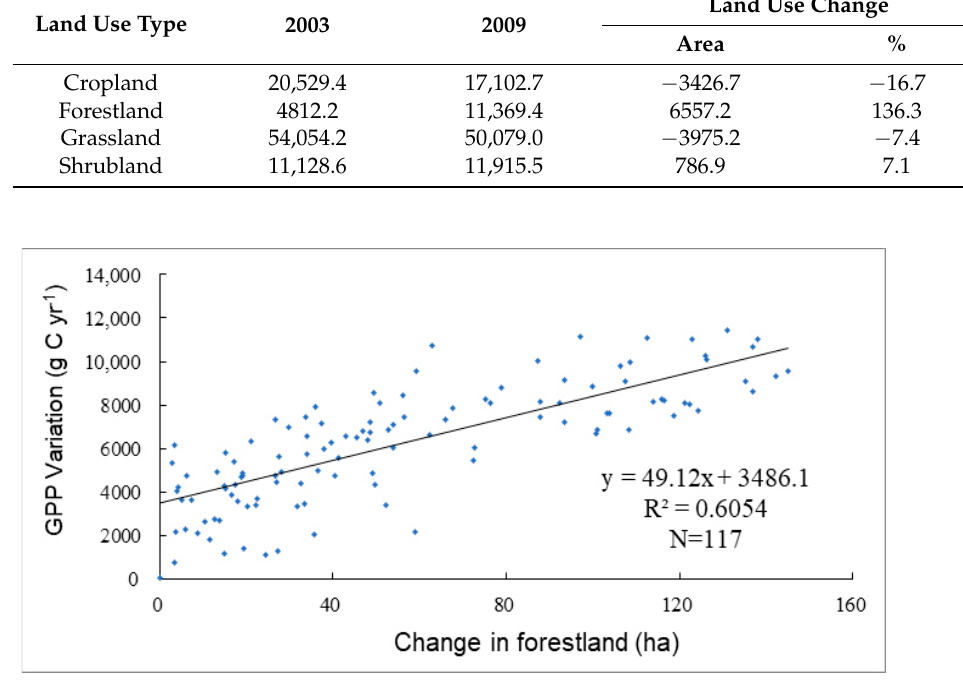
Figure 8. Relationship between changes in GPP and forestland area between 2003 and 2009 in the typical